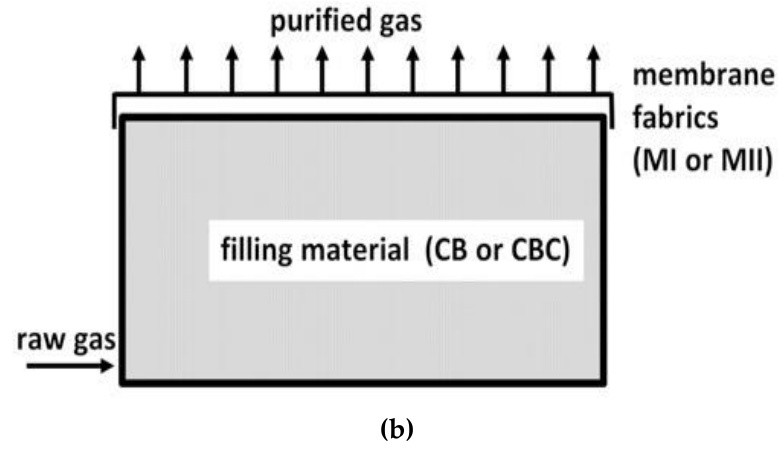
Figure 1. Single-stage ( a ) and two-stage biofiltration ( b ) .